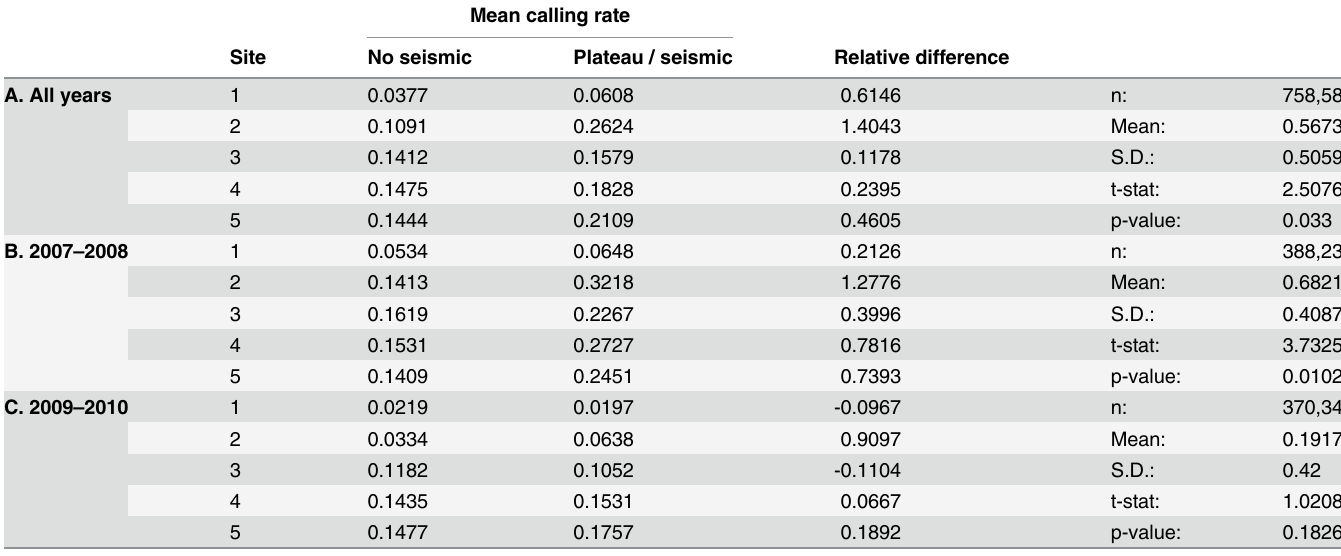
Table 5. Calling rate differences with and without the presence of airgun